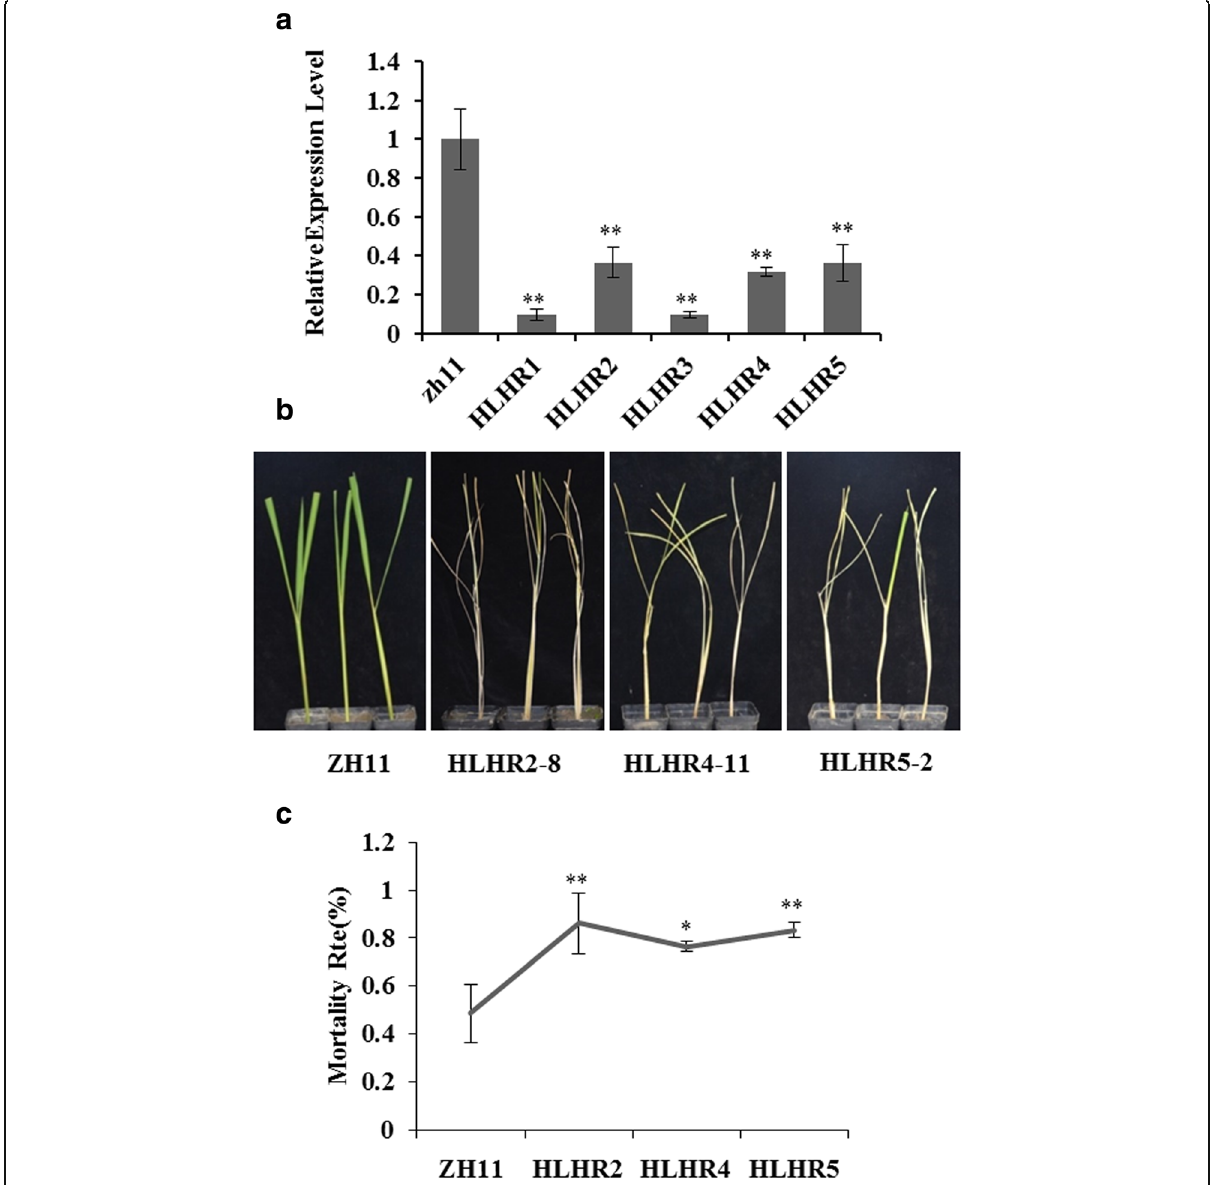
Fig. 3 Functional characterization of OsHLH61 . a Expression levels of OsHLH61 transcripts in HLHR lines and WT ( n = 3). b Phenotypes of HLHR lines after BPH infestation. c Statistic analysis of the survival rates of HLHR lines after BPH infestation ( n = 30). Asterisks in ( a ) and ( c ) represent significant differences determined by Student ’ s t -test at * P < 0.05 and ** P <